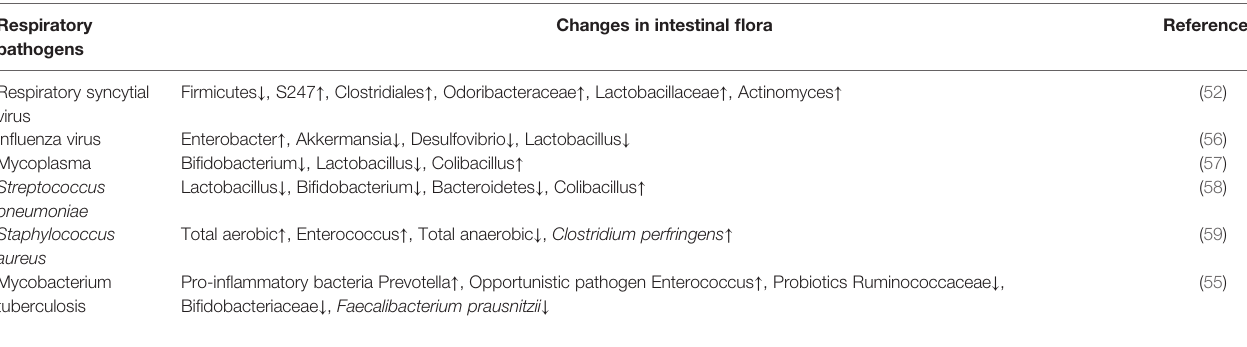
TABLE 1 | Changes in intestinal fl ora caused by respiratory pathogen